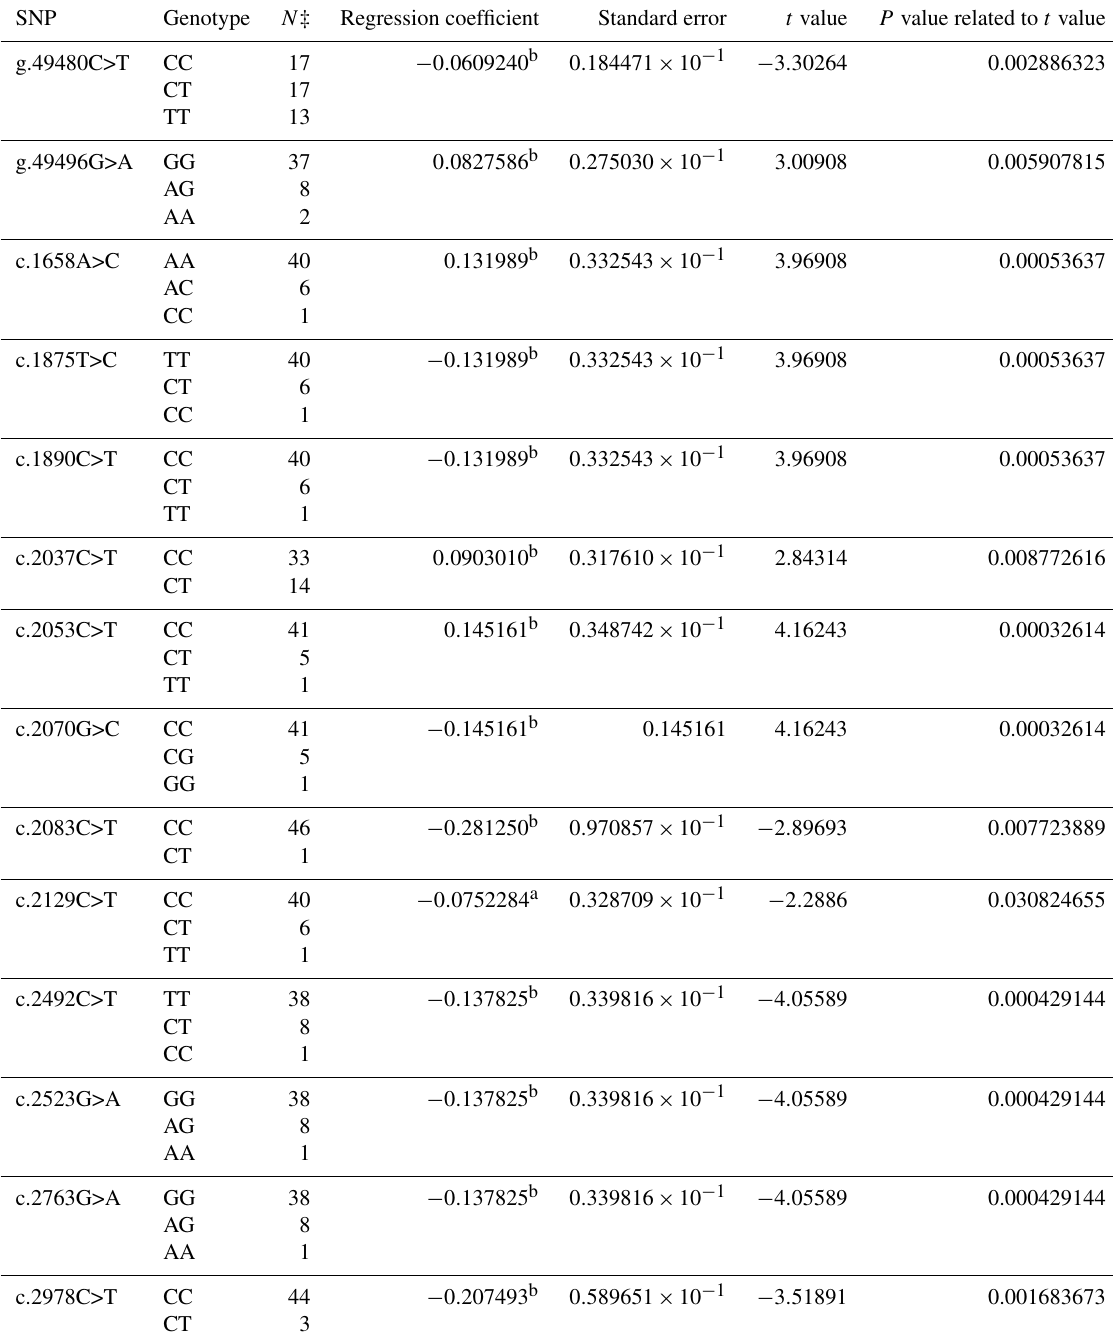
Table 2. The SNPs located in the 12th intron, 13th exon, and 3 (cid:48) UTR region in the BMPR1B gene of Ramlıç sheep, along with their significance levels and calculated regression